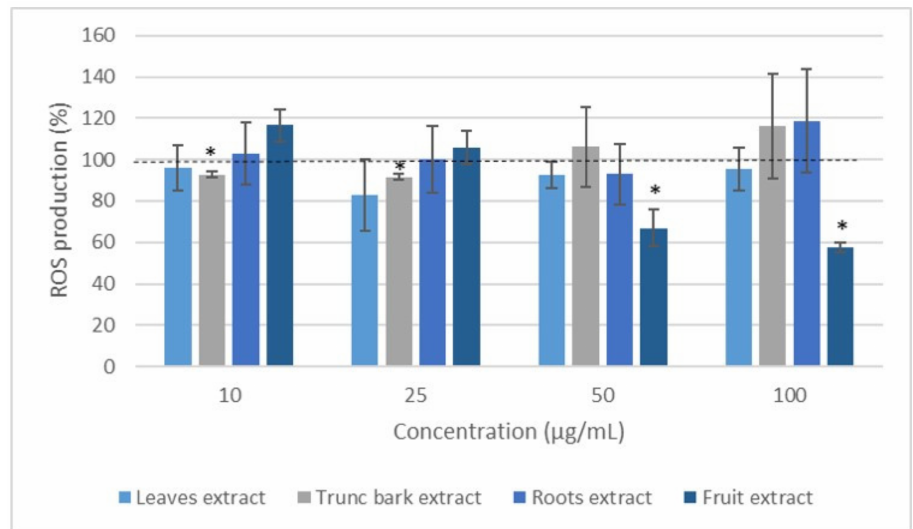
Figure 6. Effect of Crossopteryx febrifuga extracts on ROS production of blood leukocytes stimulated with PMA for 2 h. Values are expressed as percentage of the Control (cells incubated with PMA and without extract). * p < 0.05, compared with Control normalized as 100% (dotted line).